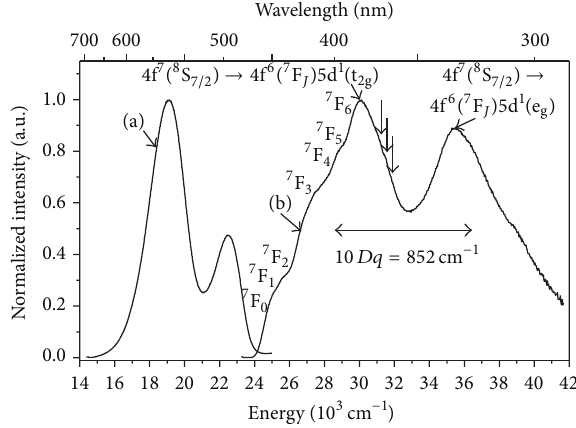
= 27 620 cm −1 ) and (b) excitation ( ̃𝜐 Figure 6: Emission ( ̃𝜐 ex 520 cm −1 ) spectra of 5 recorded at 10K. The positions marked with arrows indicate Fano antiresonances due to 8 S 7/2 → 6 I